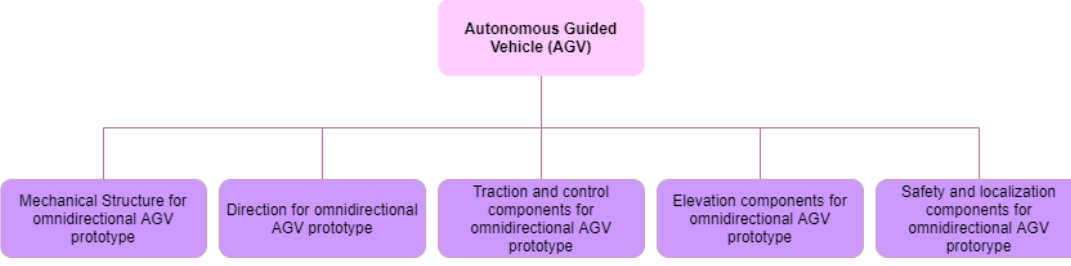
Figure 16. AGV modular breakdown.